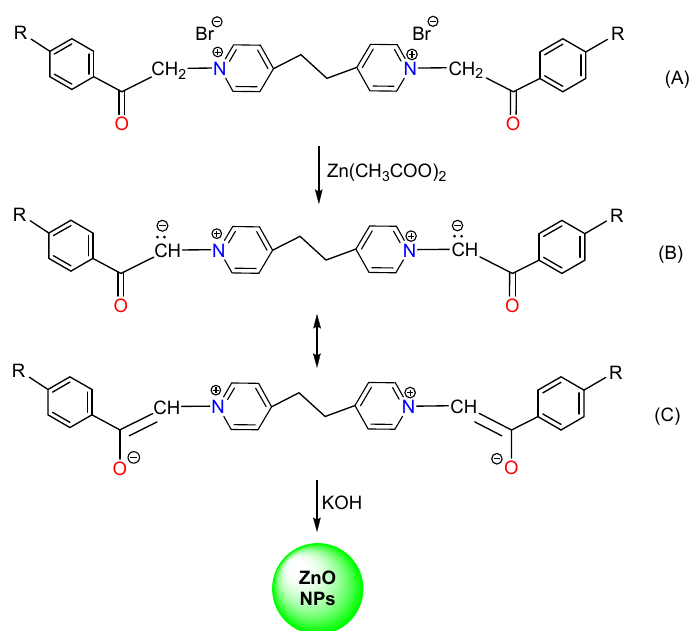
Figure 2. Aspect of the solutions in the first moments of syntheses: ( A ) ethanol solution containing PyQAs; ( B ) ethanol solution with PyQAs and zinc(II) acetate; ( C ) color change of solution (B) after heating and stirring for 10 minutes; ( D – F ) color change upon the addition of potassium hydroxide.